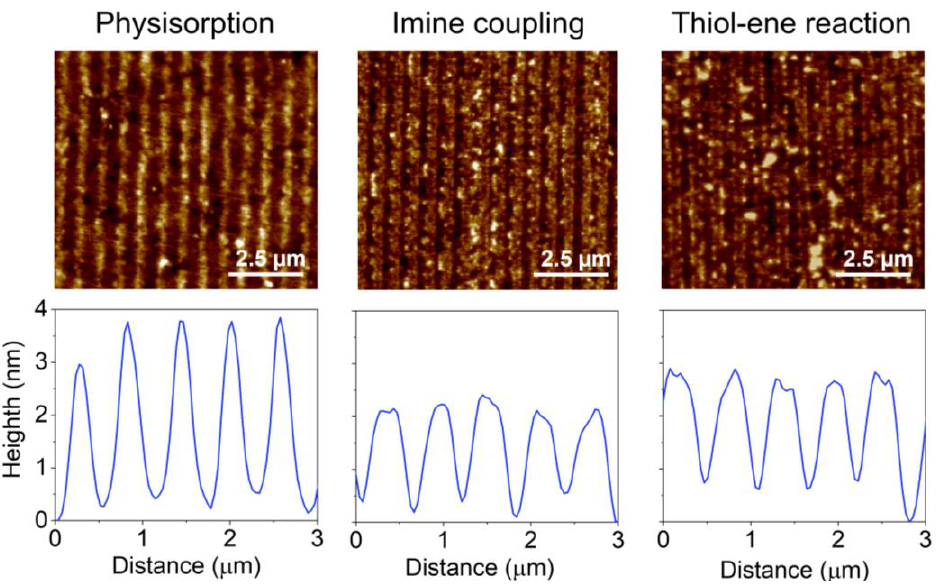
Figure 5. AFM images and height profiles of protein patterns fabricated by µCP combined with physisorption, imine coupling, and thiol-ene reaction.